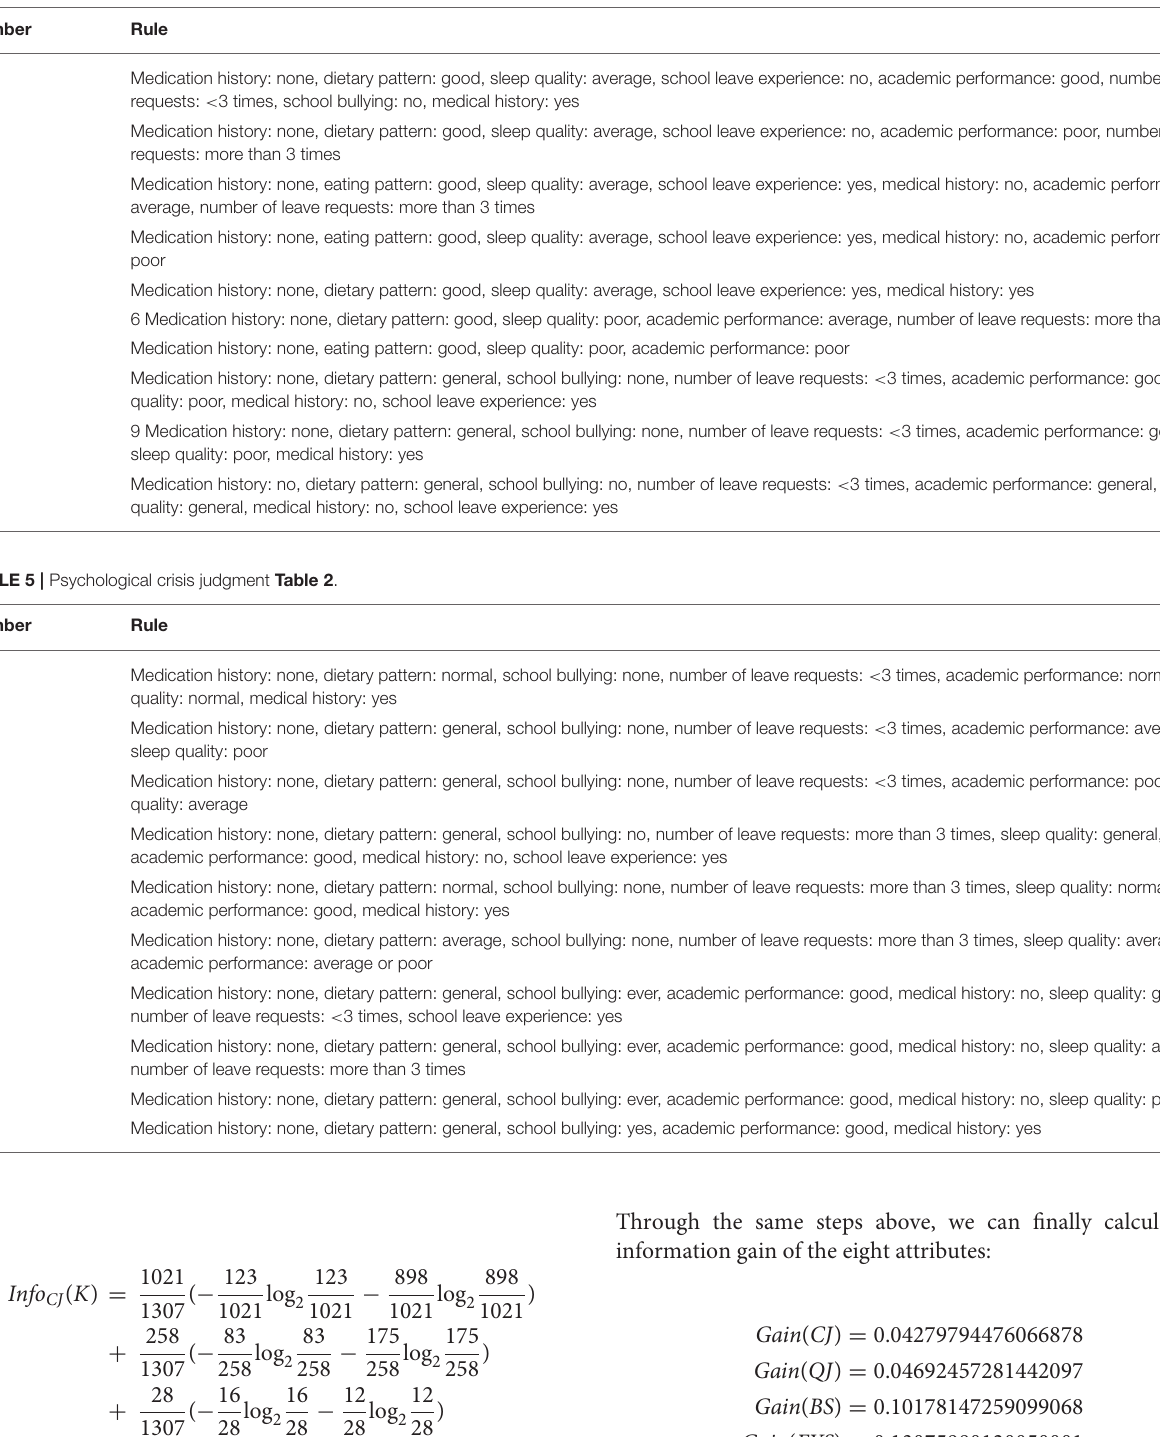
TABLE 4 | Psychological crisis judgment Table 1 .